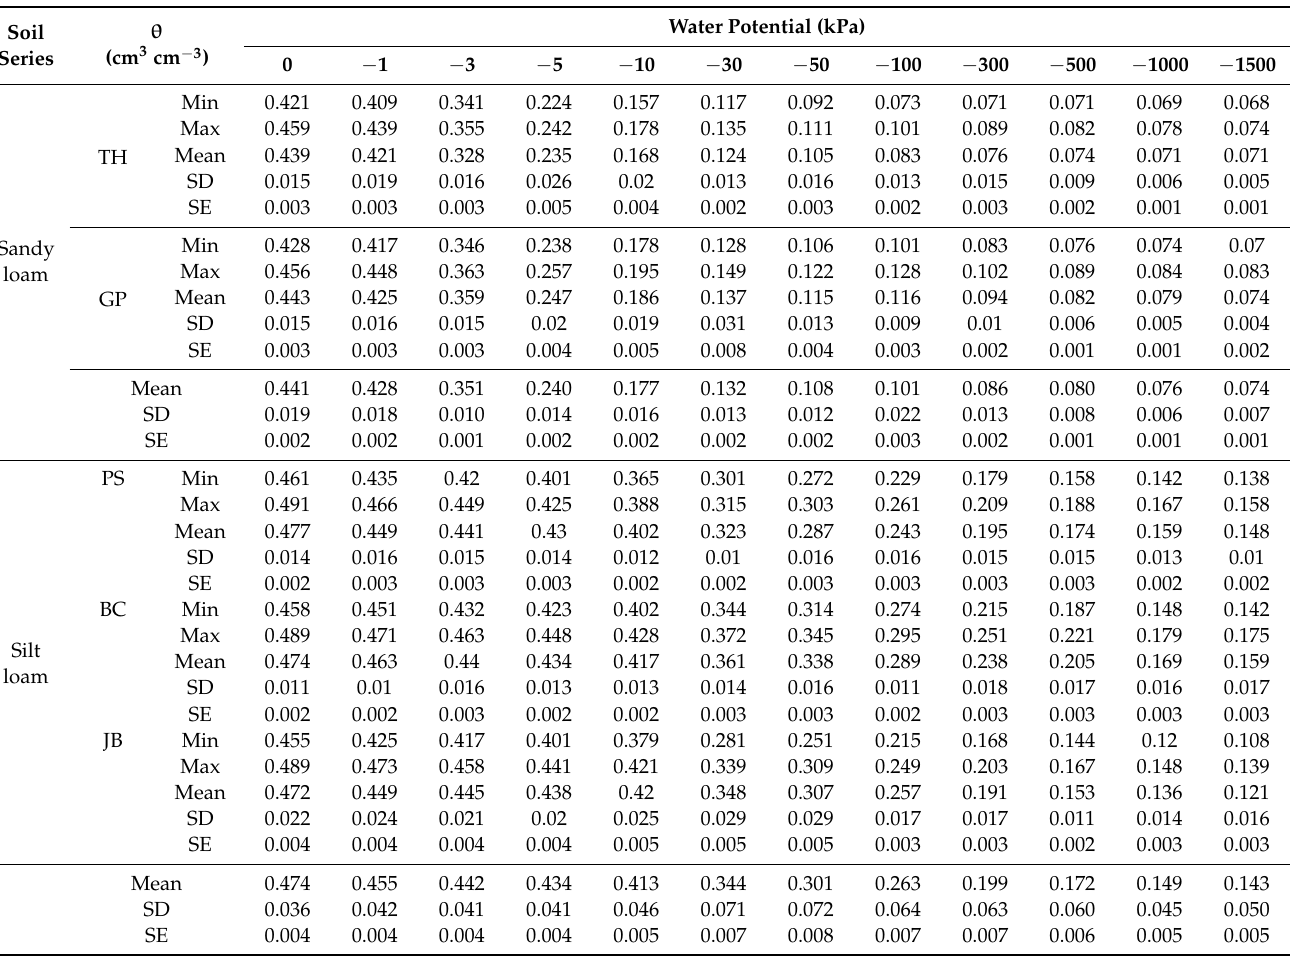
Table 3. Laboratory measured soil water contents at water potential ranging from 0 to − 1500 kPa for the five soil